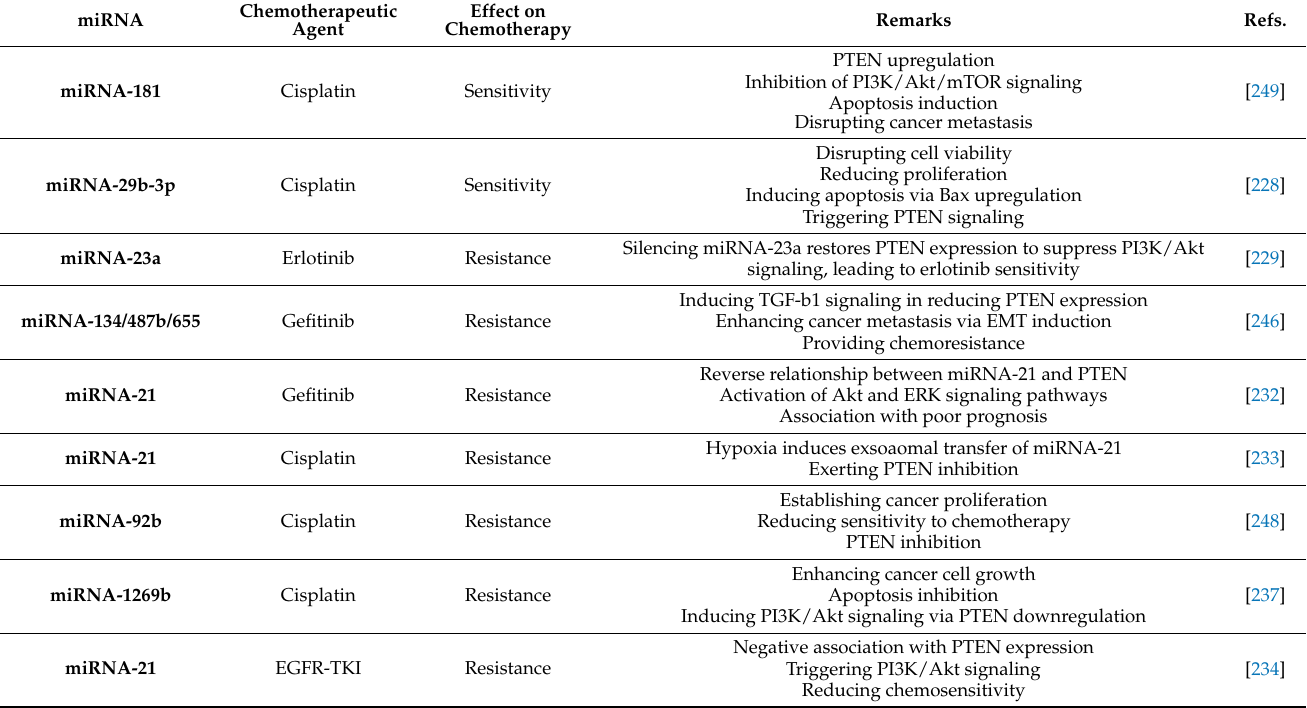
Table 4. miRNAs affecting the response of lung cancer cells to